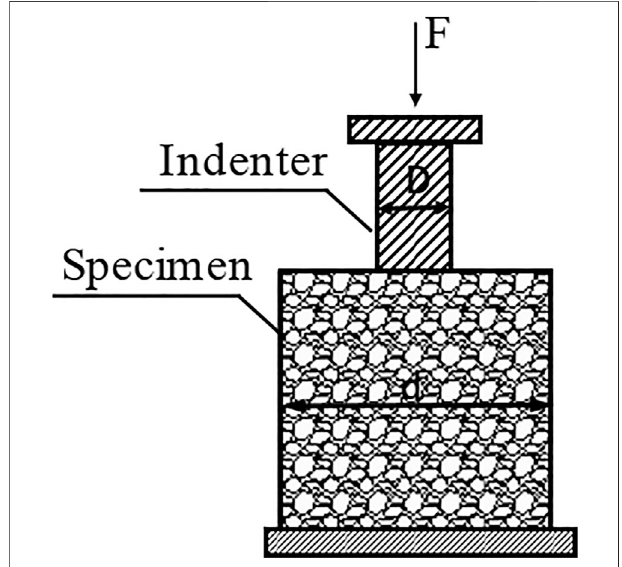
FIGURE 2 | Schematic diagram of uniaxial penetration